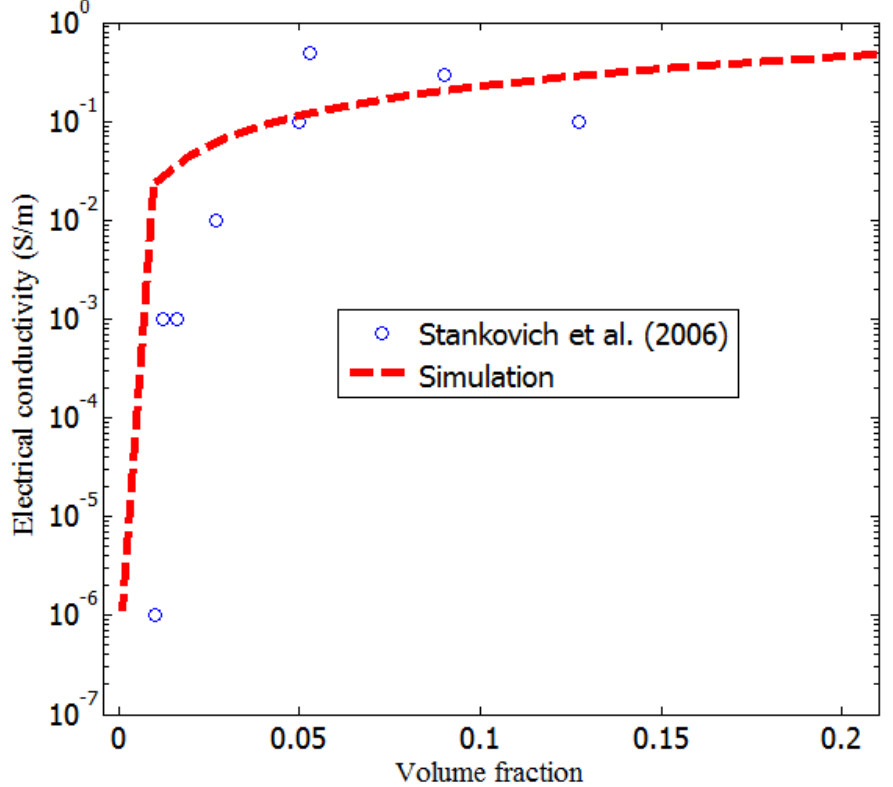
Figure 11. Comparison of the simulation results to measurement results (Stankovich et al.) [36].